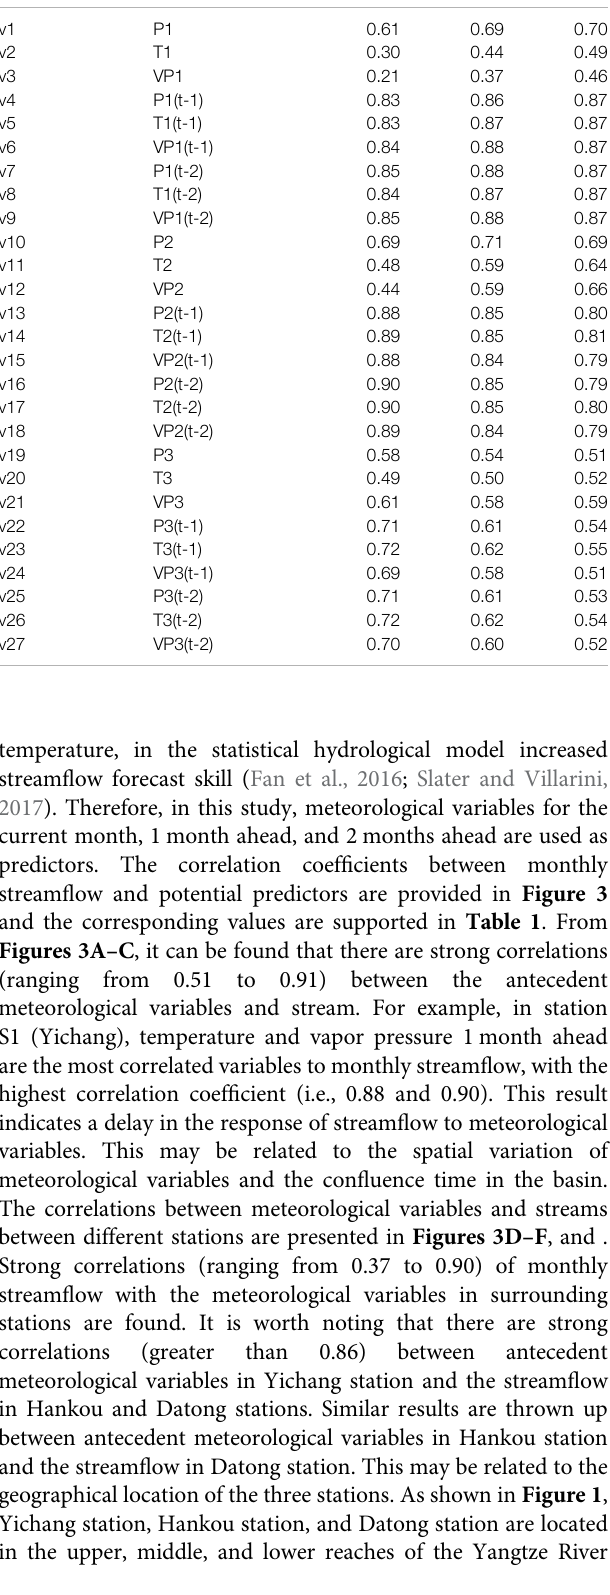
TABLE 1 | The correlation between predictors and stream fl ow. Logogram